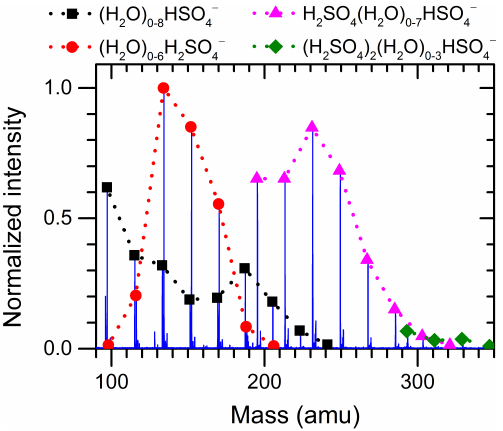
Figure 2. Negative ion mass spectrum of humidified He/H 2 SO 4 (x = 1 . 0 × 10 − 3 ) /H 2 O (x = 2 . 0 × 10 − 2 ) gas mix-